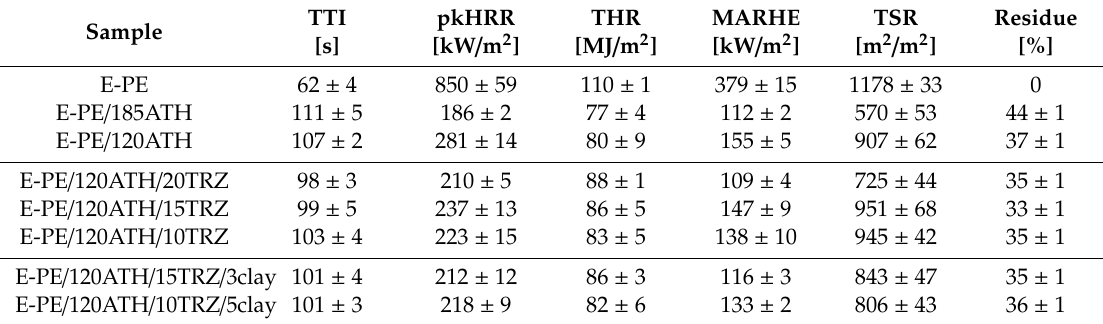
Figure 8. Heat release rate curves as a function of time for: E-PE, E-PE / 185ATH, E-PE / 120ATH, E-PE / 120ATH / 20TRZ, E-PE / 120ATH / 15TRZ, E-PE / 120ATH / 15TRZ / 3clay, E-PE / 120ATH / 10TRZ, and E-PE / 120ATH / 10TRZ / 5clay composites. Table 4. Combustion data results of E-PE and some corresponding composites by cone calorimetry.